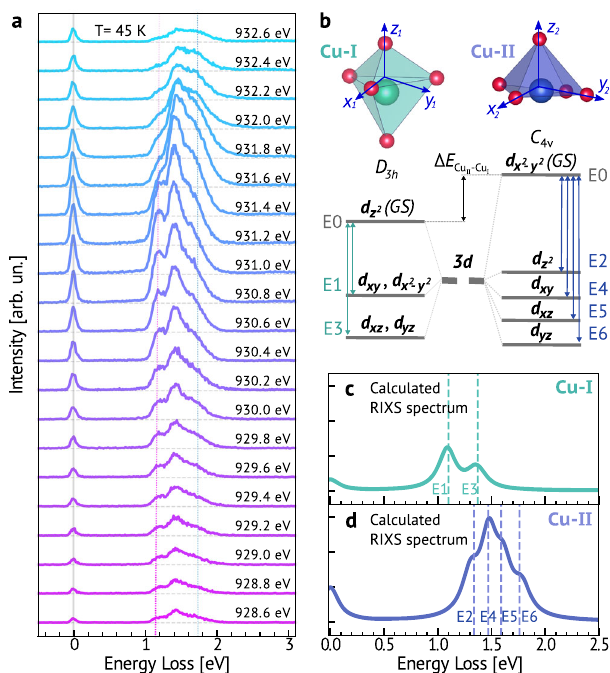
Fig. 2 dd -excitations of Cu-I and Cu-II. a Resonant inelastic X-ray scattering (RIXS) spectra as a function of incident photon energy, for a selected incident energy range: 928.6 to 932.6 eV. b Crystal- fi eld splittings of the Cu-I (Cu-II) 3 d orbitals in D 3 h ( C 4 v ) point group symmetry, respectively. The 3 d orbitals are de fi ned with respect to the local Cartesian coordinates indicated in blue. The vertical arrows labeled E1 to E5 associate the dd -excitations with the respective initial and fi nal 3 d levels. c , d Calculated RIXS responses for the individual Cu-I and Cu-II